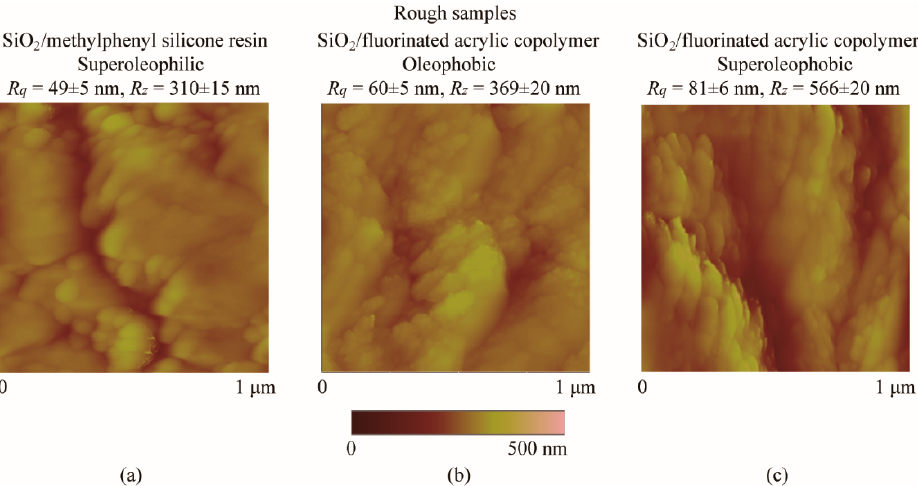
Figure 3. Scanned AFM image in air with measured RSM roughness R q and P–V distance R z of ( a ) superoleophilic, ( b ) oleophobic, and ( c ) superoleophobic surfaces. The 290-F4 contact angle measuring instrument (Rame-Hart Inc., Randolph, NJ, USA) was used to measure the contact angle and contact angle hysteresis of glycol solu- tion and aqueous solution (pH range of 3–11) droplets on the samples.